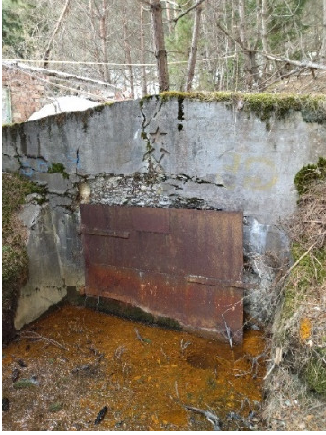
Figure 2. Water drainage at “Rosia Montana” gold mine gallery.